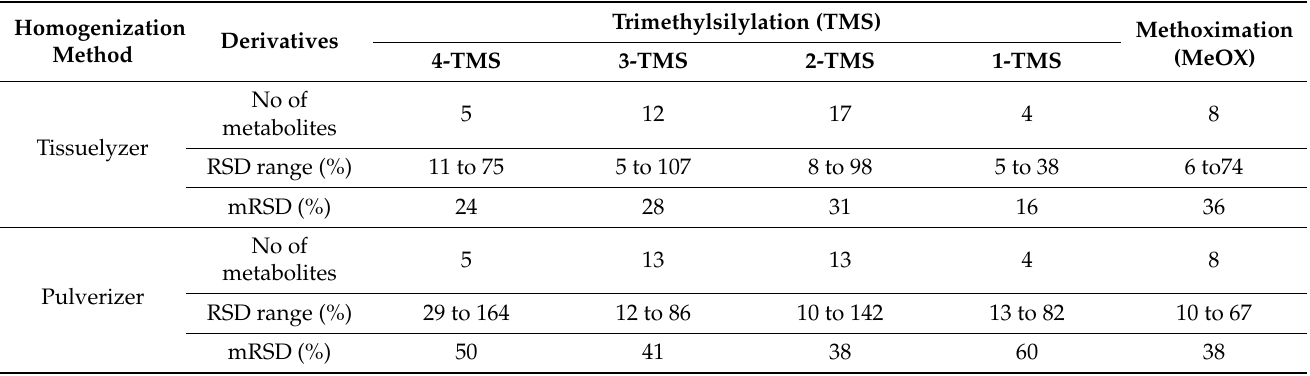
Table 2. Analysis of the repeatability of derivatives of Trimethylsilylation (TMS) and Methoximation (MeOX)